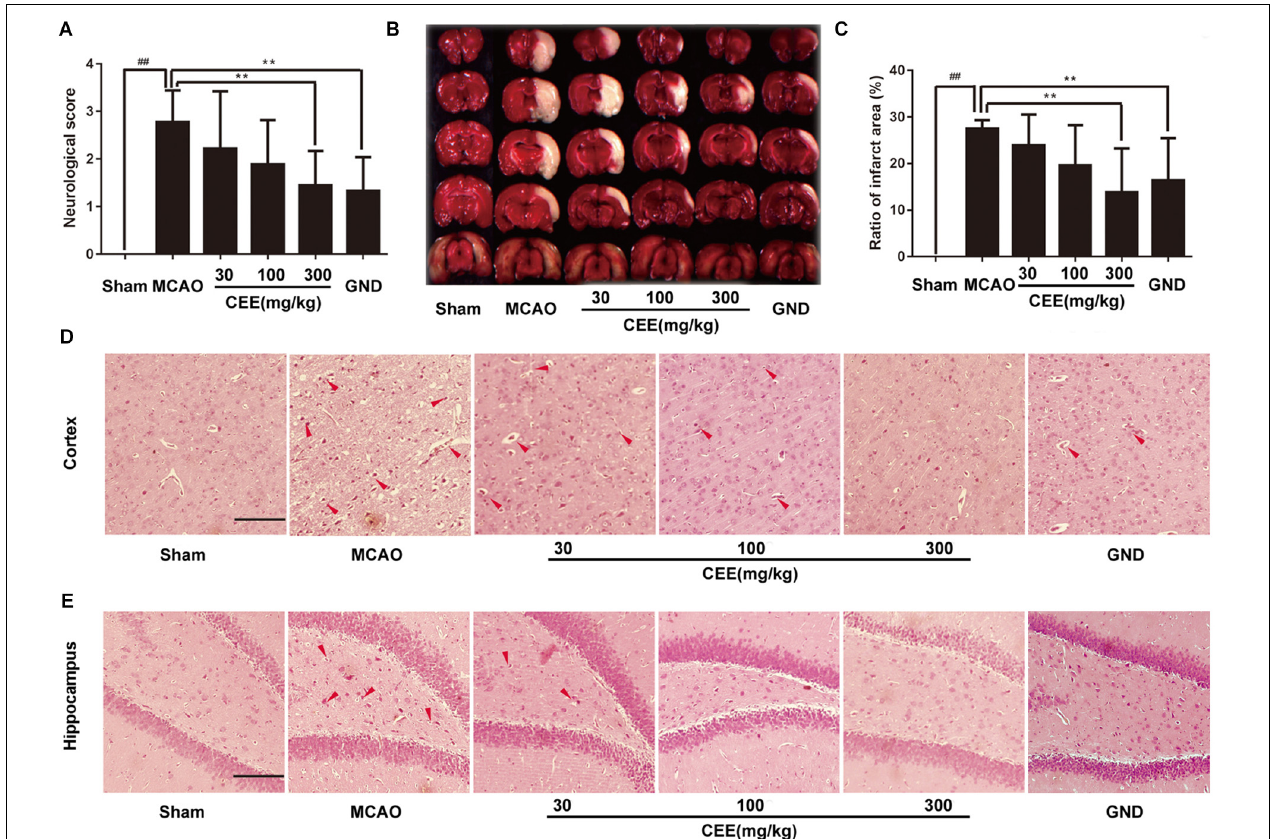
FIGURE 1 | The neuroprotective effect of Caesalpinia sappan ethanolic extract (CEE) in the rat MCAO model. (A) The neurological deficit score was evaluated after 1.5 h ischemia and 24 h reperfusion ( n = 15). (B) The cerebral infarction size as determined through TTC staining ( n = 6). (C) The percentage of ischemic lesion area, calculated using the ratio of the infarction area to the whole slice area ( n = 6). (D) Histological changes in the cerebral cortex region as detected by HE staining assay (Scale bar: 50 µ m). (E) Histological changes of cerebral hippocampal region as detected through HE staining assay (scale bar: 50 µ m). Three rats in each group and three slices for each rat were examined for HE staining assay. Data are expressed as the mean ± SD . ## P < 0.01 vs. sham group, ∗∗ P < 0.01, ∗ P < 0.05 vs. MCAO group.